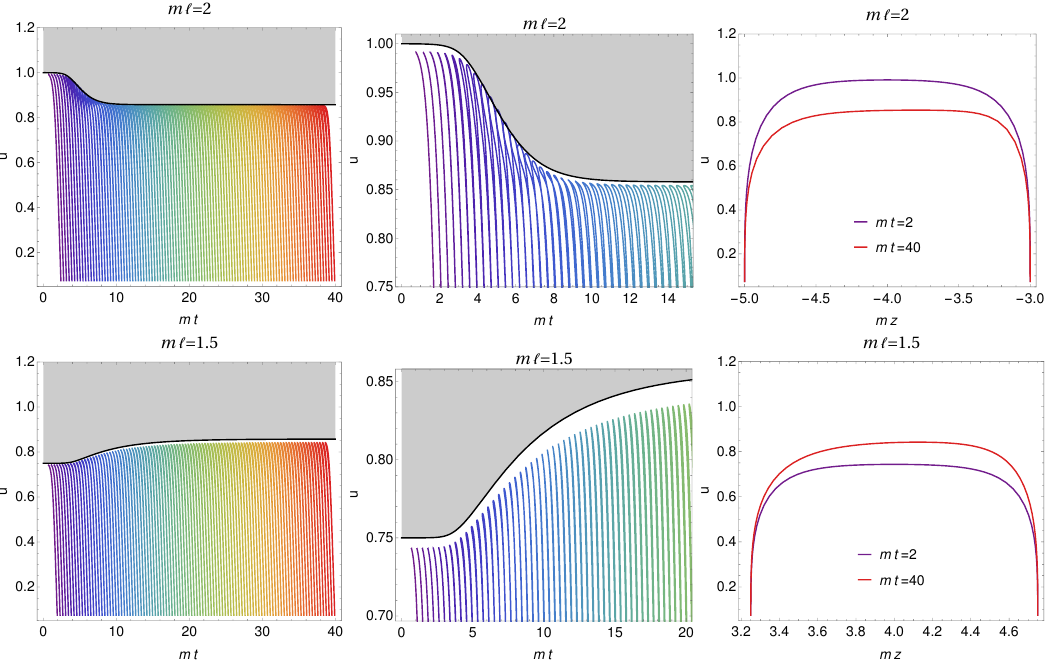
Figure 16: Cross-sections of extremal surfaces for entangling regions of size (cid:96) = 2 centered at z = − 4 (top, cold region) and of size (cid:96) = 1.5 centered at z = 4 (bottom, (cid:112) E / E = 9 / 16. The plots on the left show hot region) in the geometry with χ = C H surfaces at various different boundary times and their position relative to the appar- ent horizon whose radial position is shown in black and regions beyond the horizon are shown in gray. In the middle, we zoom into the transition region close to the hori- zon between static and boosted black brane. On the right, we show cross-sections of surfaces in the u - z plane at early ( t = 2) and late time ( t =